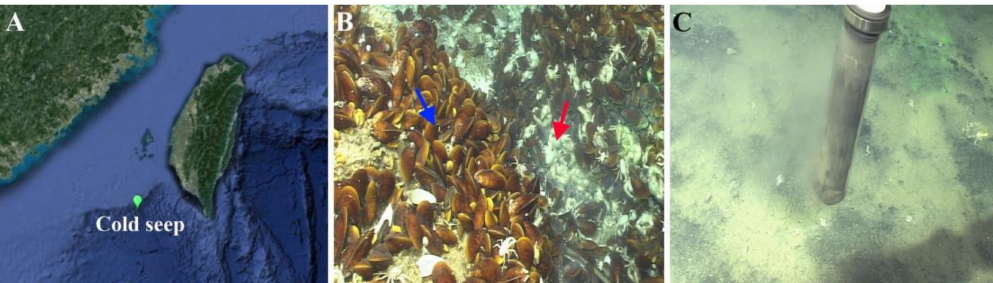
Figure 1. The location of and the sampling area in the cold seep. ( A ) The location of the cold seep is indicated. ( B ) The representative animal communities in the cold seep. Bathymodiolus platifrons and Shinkaia crosnieri are indicated with the blue and red arrows, respectively. ( C ) Sediment samples were collected using a